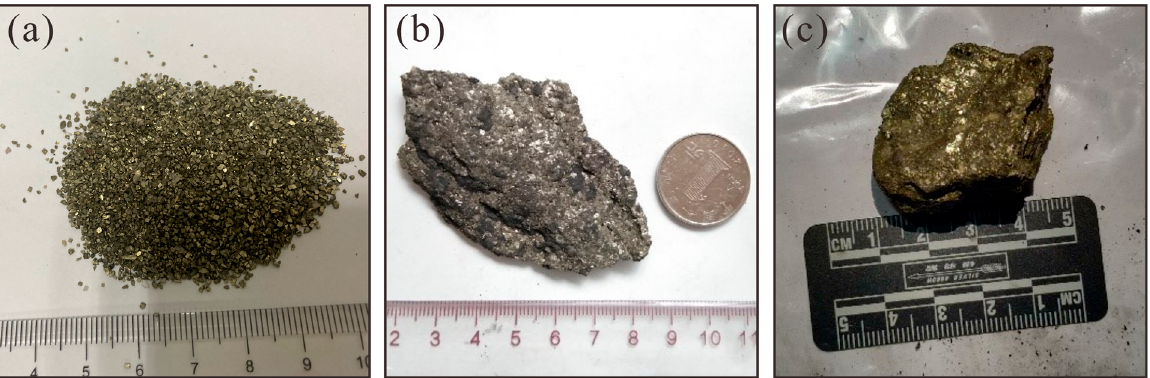
Figure 2. Macromorphology of pyrite: ( a ) is the mineral-pyrite (M1); ( b ) is the coal-pyrite from Jiashun coal mine (C1); ( c ) is the coal-pyrite from Xiongxin coal mine (C2).